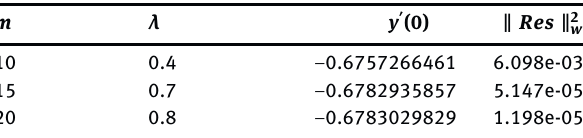
Table 5: Obtained values of y ′ (0) by the present method for various values of m and α = 0.50